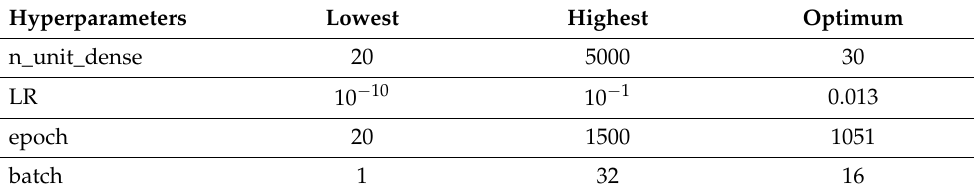
Table 3. The hyperparameter optimization details of the NN model used for the obesity level estimation.